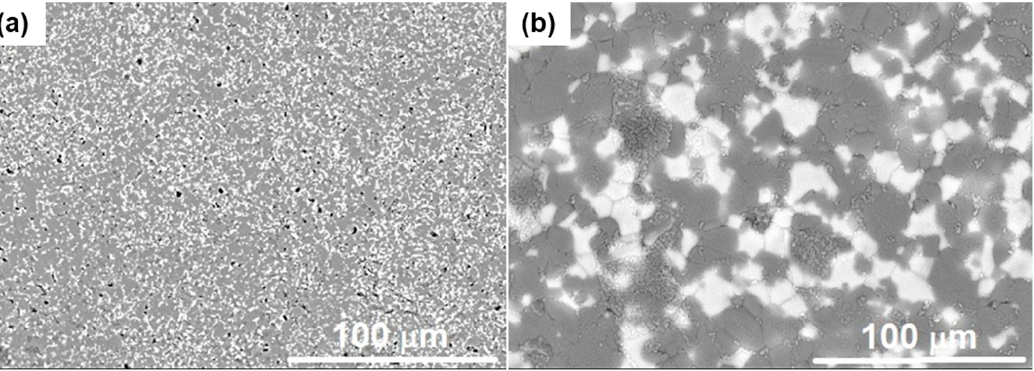
Figure 6. Microstructural features of the CZM-4A composite. SEM of polished surfaces at low magnification ( a ), and thermally etched surface at high magnification ( b ). White small grains: CaZrO 3 . Very small and medium light gray grains: Al 2 O 3 . Larger dark grains: MgAl 2 O 4 . Figure 4b shows the light gray grains of calcium zirconate (CZ) and the dark grains of MgO. CZ grains vary in size between approximately 1 and 4 µ m while MgO grains are between 1 and 2 µ m. This material is totally dense because no open or closed porosity is observed, which is in accordance with the results in Table